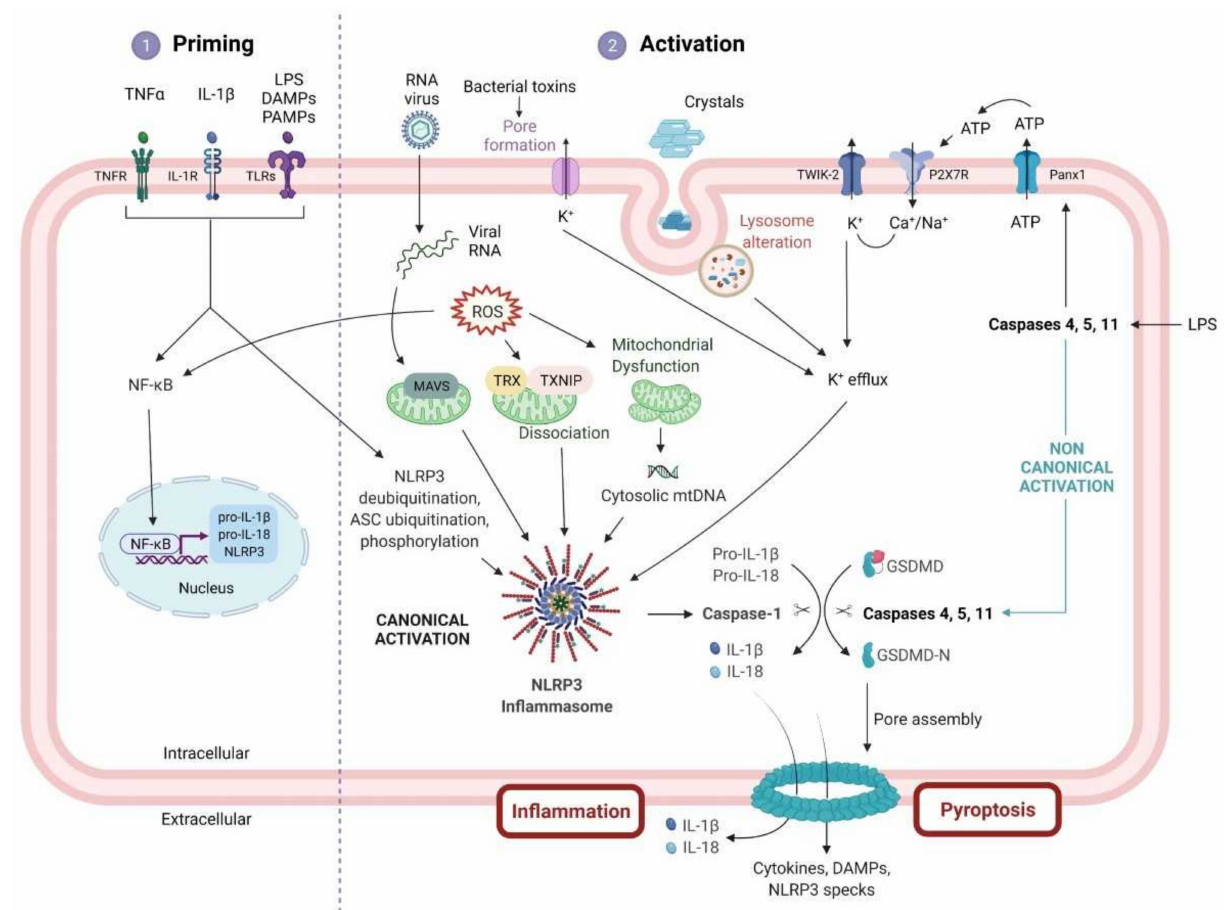
Figure 2. NLRP3 inflammasome priming and activation pathway. Activation of the NLRP3 inflammasome signaling pathway requires two signals. The signal 1 (cid:13) or priming ( left ) is triggered by the stimulation of cytokine receptors (TNFR and IL-1R) or TLRs via several activators, such as LPS, DAMPs or PAMPs. This interaction with their respective receptors will then lead to the upregulation of several inflammasome components (NLRP3, pro-IL-1 β and pro-IL-18) via the NF- κ B pathway as well as to posttranslational modifications of ASC and NLRP3 protein. Signal 2 (cid:13) or activation ( right ) is triggered by numerous PAMPs or DAMPs including virus, crystals, protein aggregates, LPS, bacterial toxins, or ATP, which will, in turn, activate multiple signaling cascades. The latter involves, among others, K + efflux, ROS production, lysosomal dysfunction, and the release of mitochondrial DNA in the cytosol. These signals lead eventually to the interaction between NLRP3, ASC and pro-caspase-1, allowing the formation of the NLRP3 multiprotein inflammasome complex. Once activated, caspase 1, the head of the canonical activation, cleaves the pro-IL-1 β , pro-IL-18 and Gasdermin D (GSDMD) into their mature forms, triggering pyroptosis and inflammatory cytokines release. In addition, another way leading to pyroptosis is the noncanonical pathway, where cytosolic lipopolysaccharide (LPS), via caspases 4, 5 and 11, can also cleave GSDMD and form pores into the cellular membrane. IL-1R1, IL-1 receptor type 1; PANX1, pannexin 1; ROS, reactive oxygen species; TNFR, tumor necrosis factor receptor; TRX,